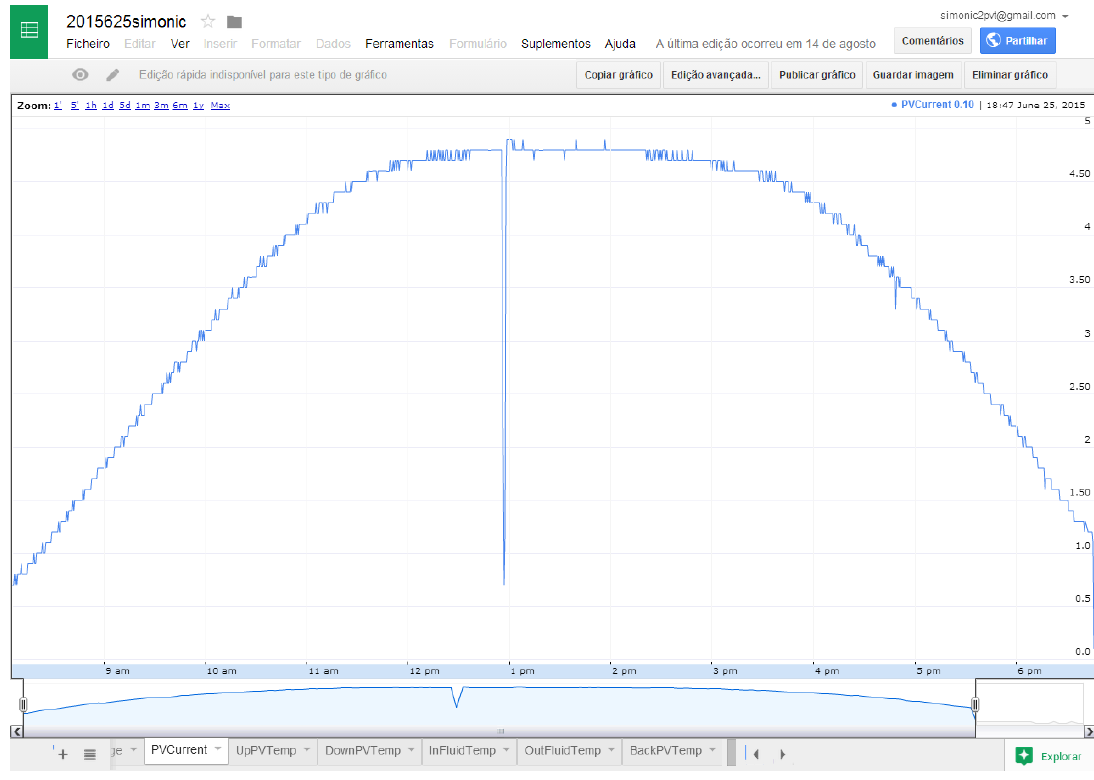
Figure 6: Print screen of graph for electrical